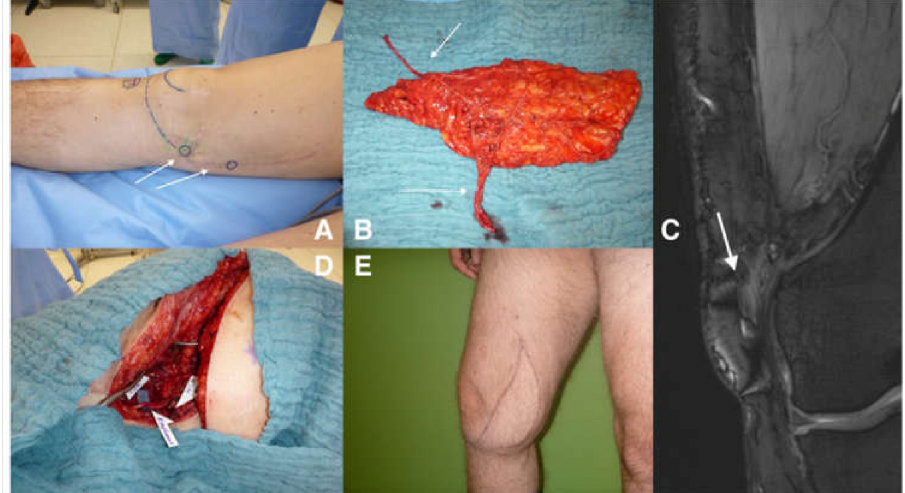
Figure 4. Clinical demonstration of the procedure. ( A ) shows the areas with positive Hoffmann–Tinel sign after arthroscopy of the knee. The neuroma formation was also detected in MRI scans ( C ). ( B ) shows the cutaneous branch beside the vascular pedicle, which was anastomosed to the femoral artery and greater saphenous vein ( D ), as well as coaptated with the remaining saphenous nerve. Final result is not only functional but also cosmetically appealing for the patient ( E